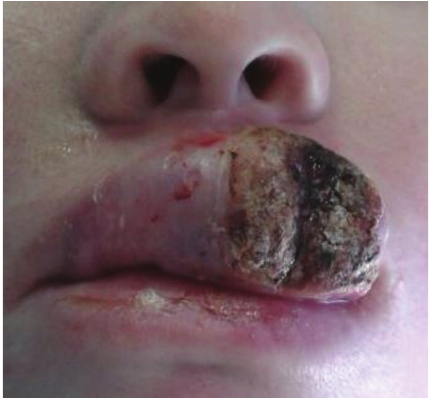
Figure 2: A 21-year-old HIV-seropositive Black albino woman with an exophytic crusted SCC of the upper lip, twelve months after she first noticed a small painless erosion. There was neither local lymph node involvement nor distant metastasis, and microscopically the carcinoma was moderately